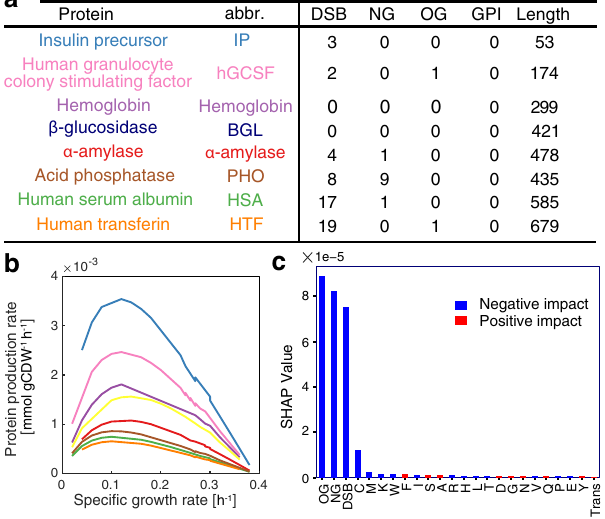
Fig. 4 Simulation of recombinant protein production. a Overview of protein features for eight recombinant proteins produced by S. cerevisiae . See Supplementary Data 7 for detailed information. Abbr.